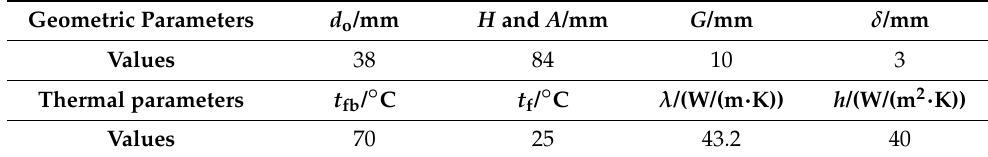
Table 2. Parameters of H-type fins in the